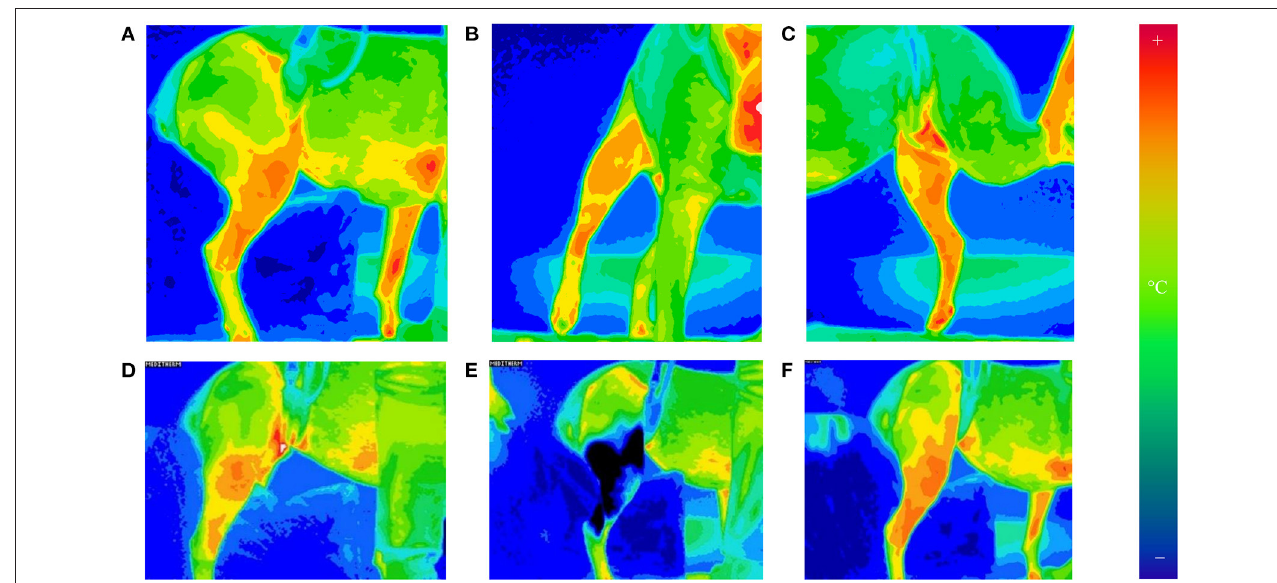
FIGURE 1 | Thermographic images of orthogonal views of the operated stifle [lateral (A) , cranial (B) , and medial (C) ]. Images taken of the lateral, cranial, and medial aspects of the stifle at 30-min intervals until equilibrated. The camera was set to a 16 ◦ C temperature scale and 16-shade color map, ranging from violet (coldest) to red (hottest). Thermography of lateral stifle at equilibrium is depicted on (D) . The stifles were equilibrated when two consecutive sets of images exhibit (30 min apart) similar heat distribution patterns globally. This was found to consistently occur by 1h after bandage removal. After 20 min of cryotherapy, thermography of lateral stifle was obtained on (E) . Rewarming of the stifle is seen on (F) . Thermographic images of orthogonal views of the operated stifle © 2021 by Sang Chul Woo is licensed under CC BY 4.0. To view a copy of this license, visit http://creativecommons.org/licenses/by/4.0/.